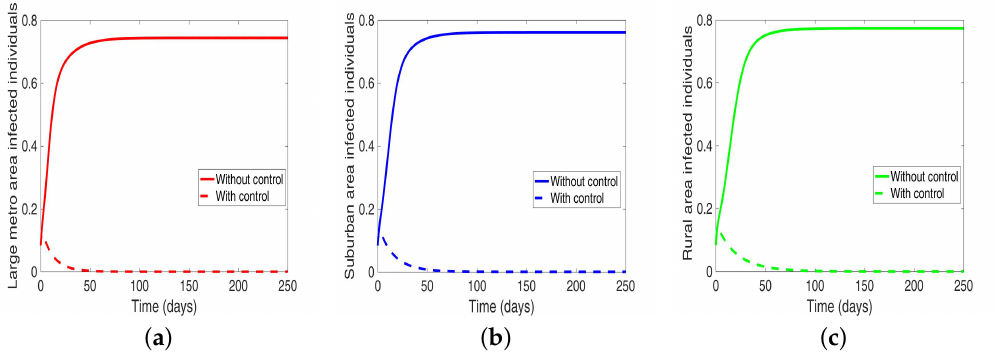
Figure 11. MRSA model simulation with movement, disease and behavioral control in large metro area only. ( a ) Infected individuals in large metro area. ( b ) Infected individuals in suburban area. ( c ) Infected individuals in rural area. Parameter values used are given in Tables